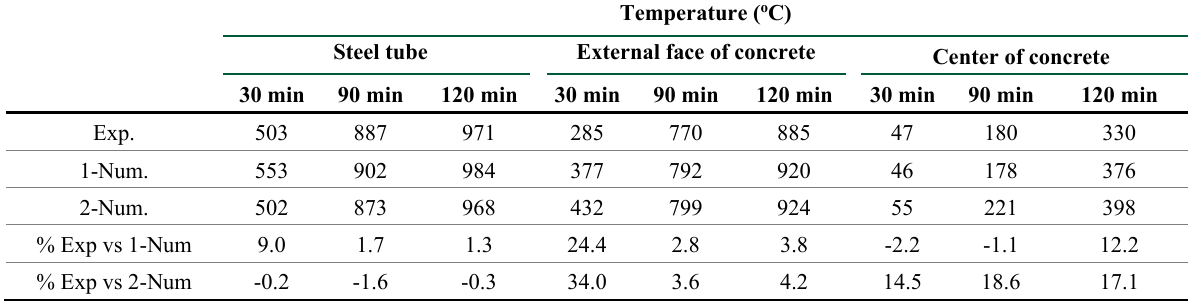
Table 4 – Temperatures found in experimental and numerical models.